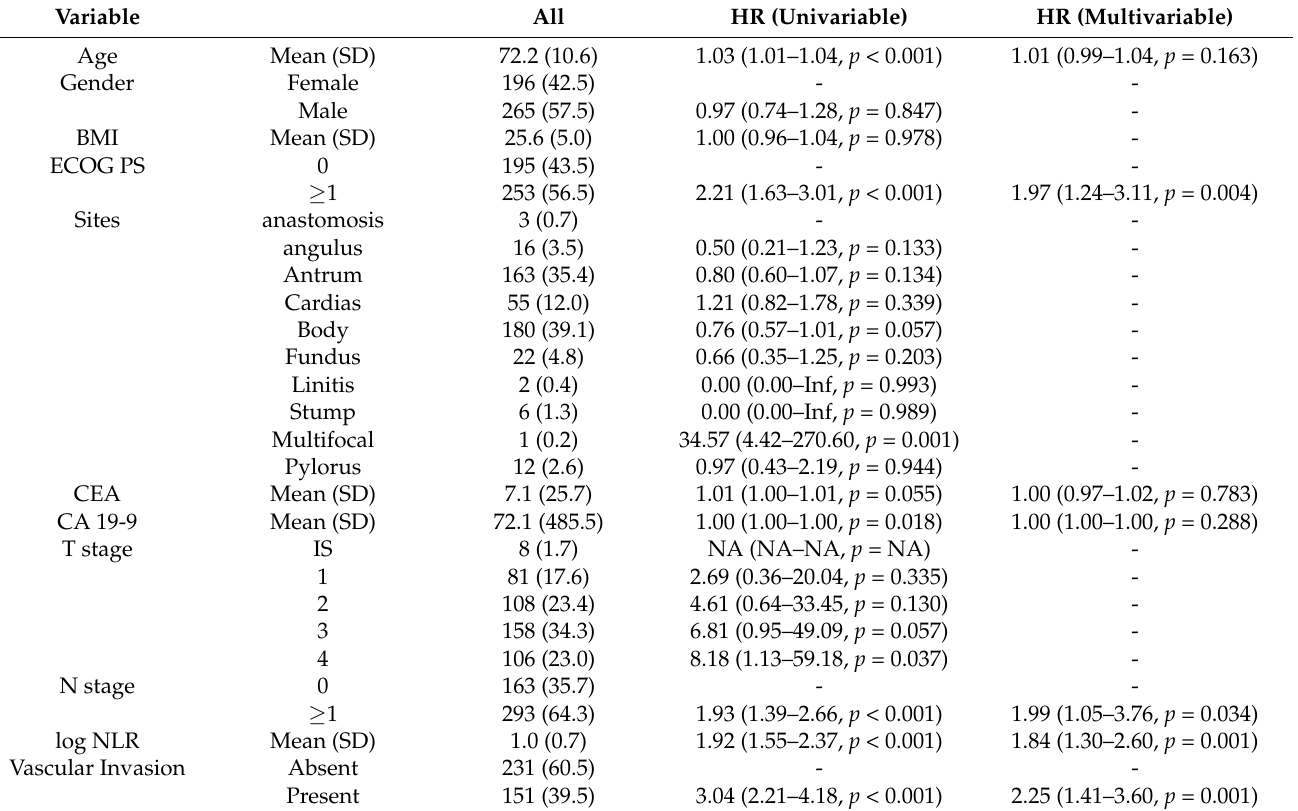
Table 2. Univariate and multivariate Cox regression analysis of factors related to